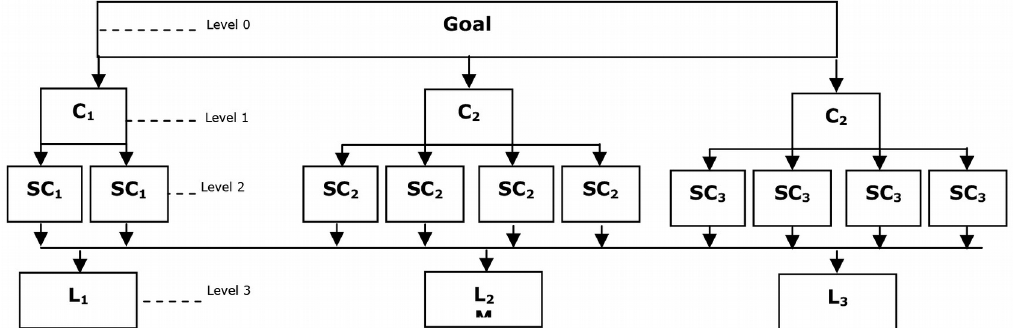
Figure 1. Multi-level hierarchy for selecting locations for infectious waste